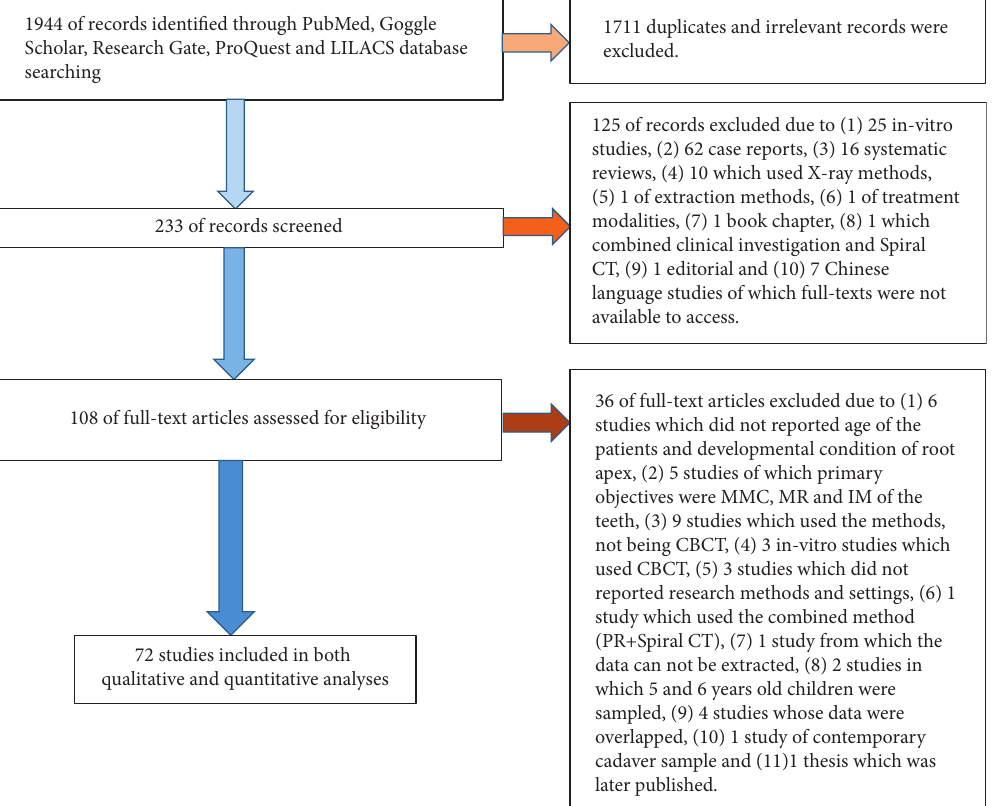
Figure 4: Flow diagram of identifying, screening, and processing the studies.